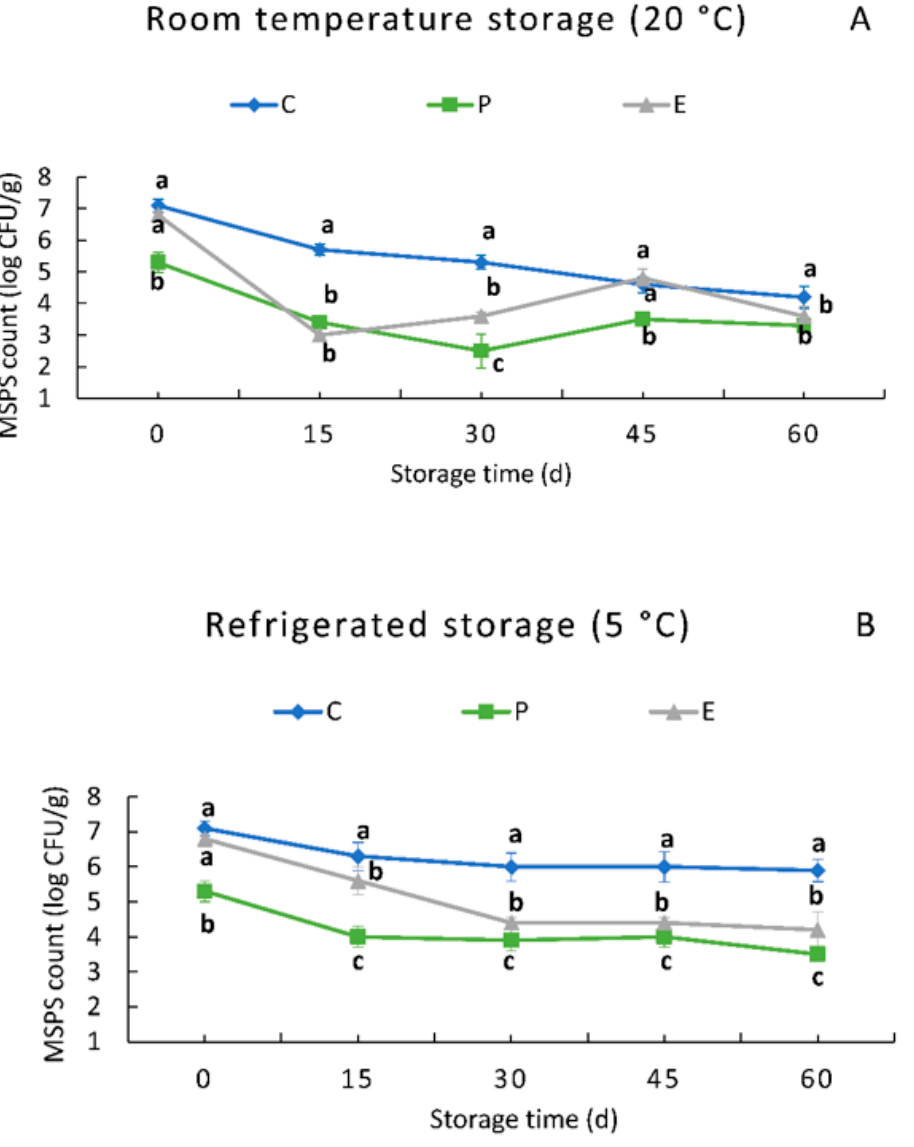
Figure 5. ( A ): MSPS counts (means ± standard deviations) during 60 d of room temperature storage (20 ◦ C) of Salamines Criollos formulated with microencapsulated L. plantarum BFL (E) and free L. plantarum BFL (P). ( B ): MSPS counts (means ± standard deviations) during 60 d of refrigerated storage (5 ◦ C) of Salamines Criollos formulated with microencapsulated L. plantarum BFL (E) and free L. plantarum BFL (P). The different letters indicate significant differences between treatments on the same day under the same storage temperature.